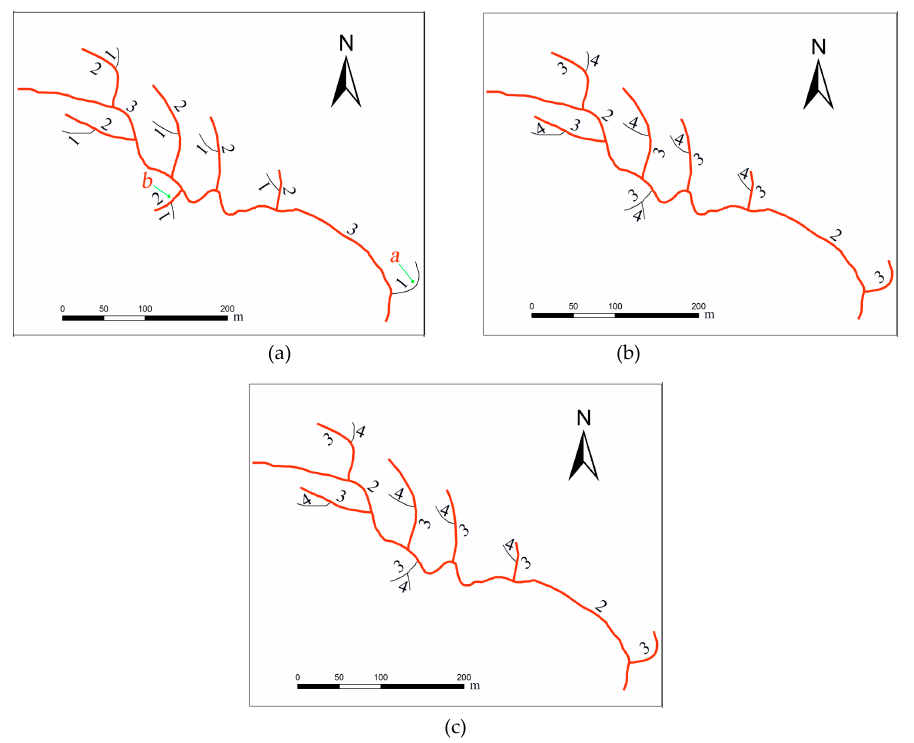
Figure 11. Comparison of the selections in a shallow branch: ( a ) selection result based on the top-down coding method, ( b ) selection result based on bottom-up coding method and ( c ) selections based on the hybrid coding method (the selection results are shown as red lines, and the original rivers are shown as black lines).